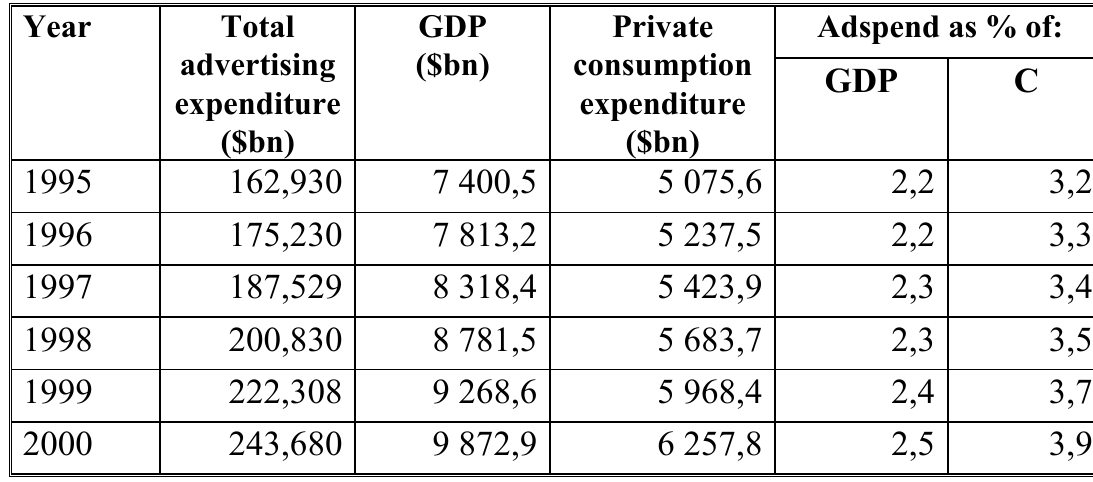
USA advertising expenditure, gross domestic product and private consumption expenditure, 1995-2000